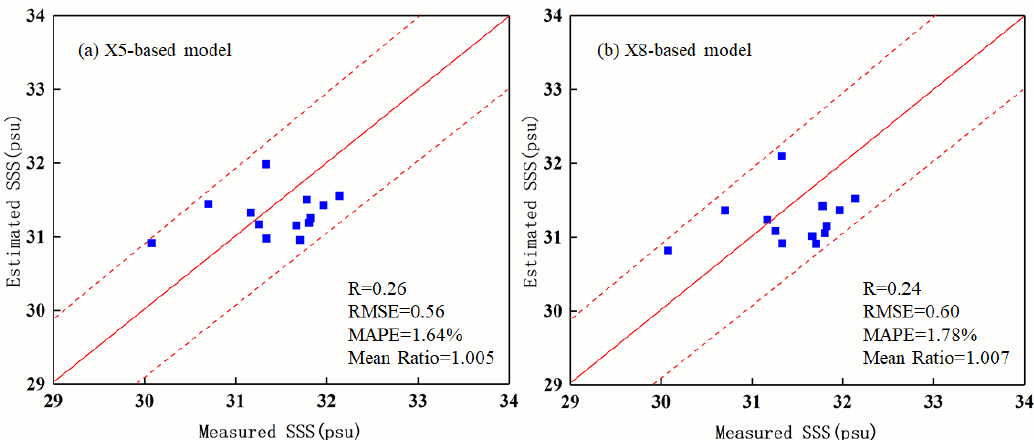
Figure 6. Scatter plots of the measured SSS versus the satellite-derived SSS from GOCI data using ( a ) the X5-based model and ( b ) the X8-based model. Note that both R values are not very significant, with p = 0.42 and p = 0.25 for ( a ) and ( b ) figures, respectively. The shown red dotted lines are ± 3% error